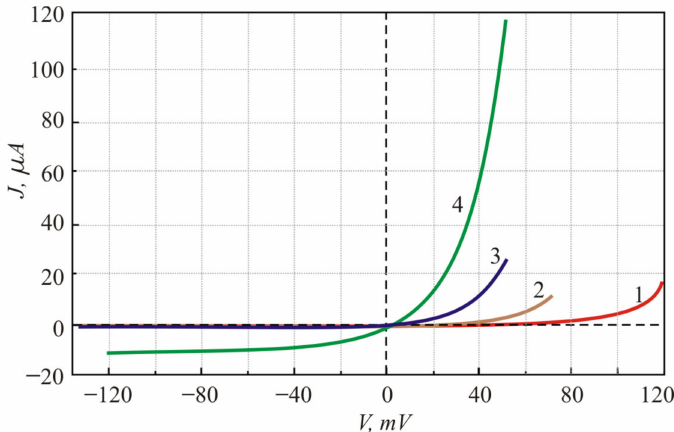
Figure 3. Current–voltage characteristics of the In-doped PbTe photodiode at different temperatures: 1—80 K; 2—100 K; 3—120 K; 4—150